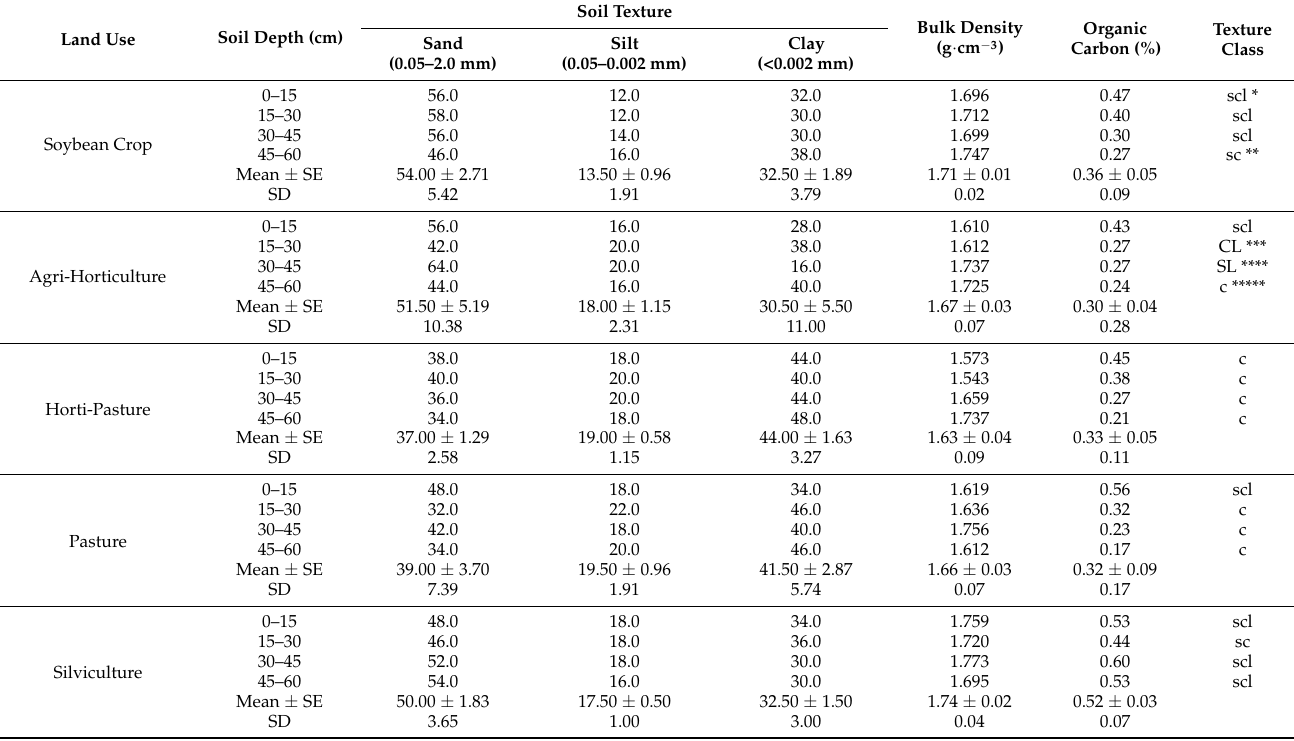
Table 1. Physico-chemical soil properties under different land use